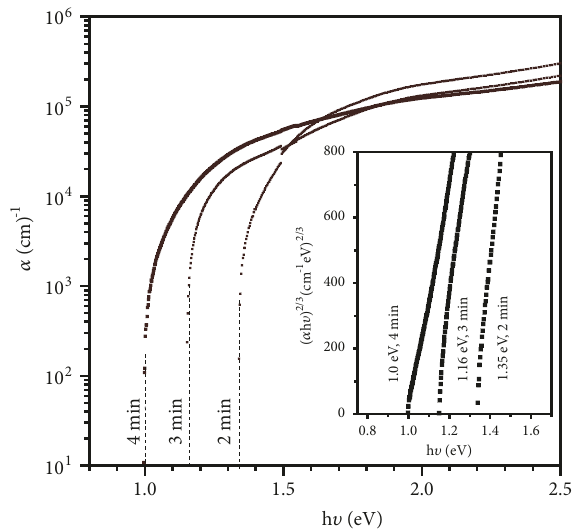
Figure 5: Optical absorption coefficient ( 𝛼 ) of PbS thin films. Inset shows optical band gap values.